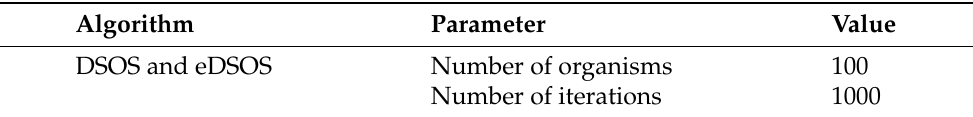
Table 4. Parameter